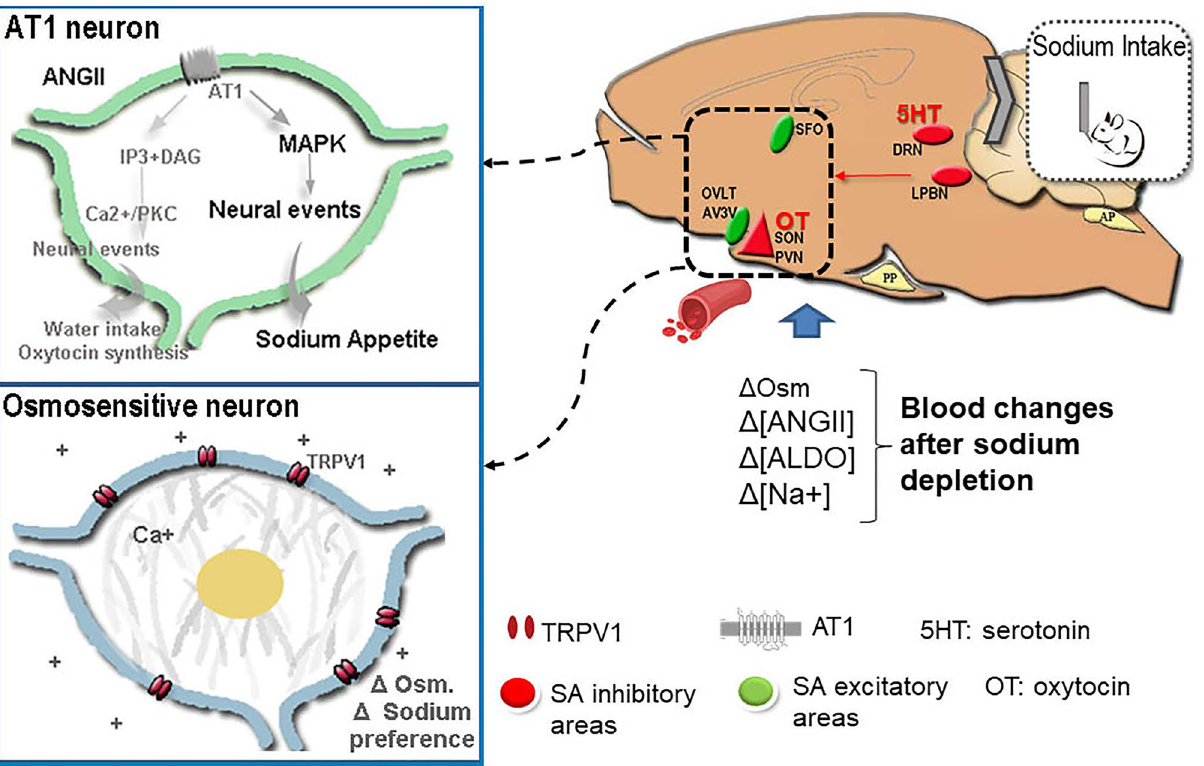
Figure 1. Schematic representation of different areas and mechanisms implicated in the regulation of sodium appetite after sodium depletion. Panel of AT1 neuron: AngII released after SD binds to the AT1 receptor activating the intracellular MAPK pathway to trigger sodium appetite. Osmosensitive neuron panel: changes in osmolarity, induced by SD, modify cell volume and the activity of TRPV1 channel that modulates sodium preference. DRN: dorsal raphe nucleus, LPBN: lateral parabrachial nucleus, SON: supraoptic nucleus, PVN: paraventricular nucleus, OVLT: oraganum vasculosum of the lamina terminalis; AV3V: anteroventral third ventricle area; SFO: subfornical organ, MAPK: mitogen-activated protein kinase, IP3: Inositol trisphosphate, DAG: diacylglycerol, AT1: angiotensinerigic receptor type 1, TRPV1: Transient receptor potential vanilloid subtype 1. Osm: Osmolarity, ANGII: Angiotensin II, ALDO: